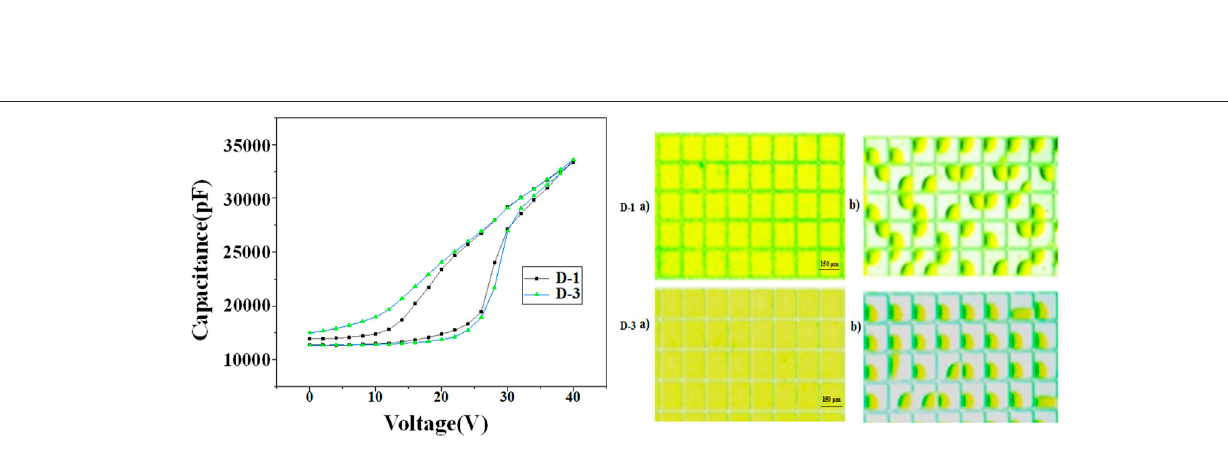
FIGURE 5 | Back fl ow time of electrowetting display devices formulated by Dyes D-1/3. (A) : D-1; (B) : D-3.